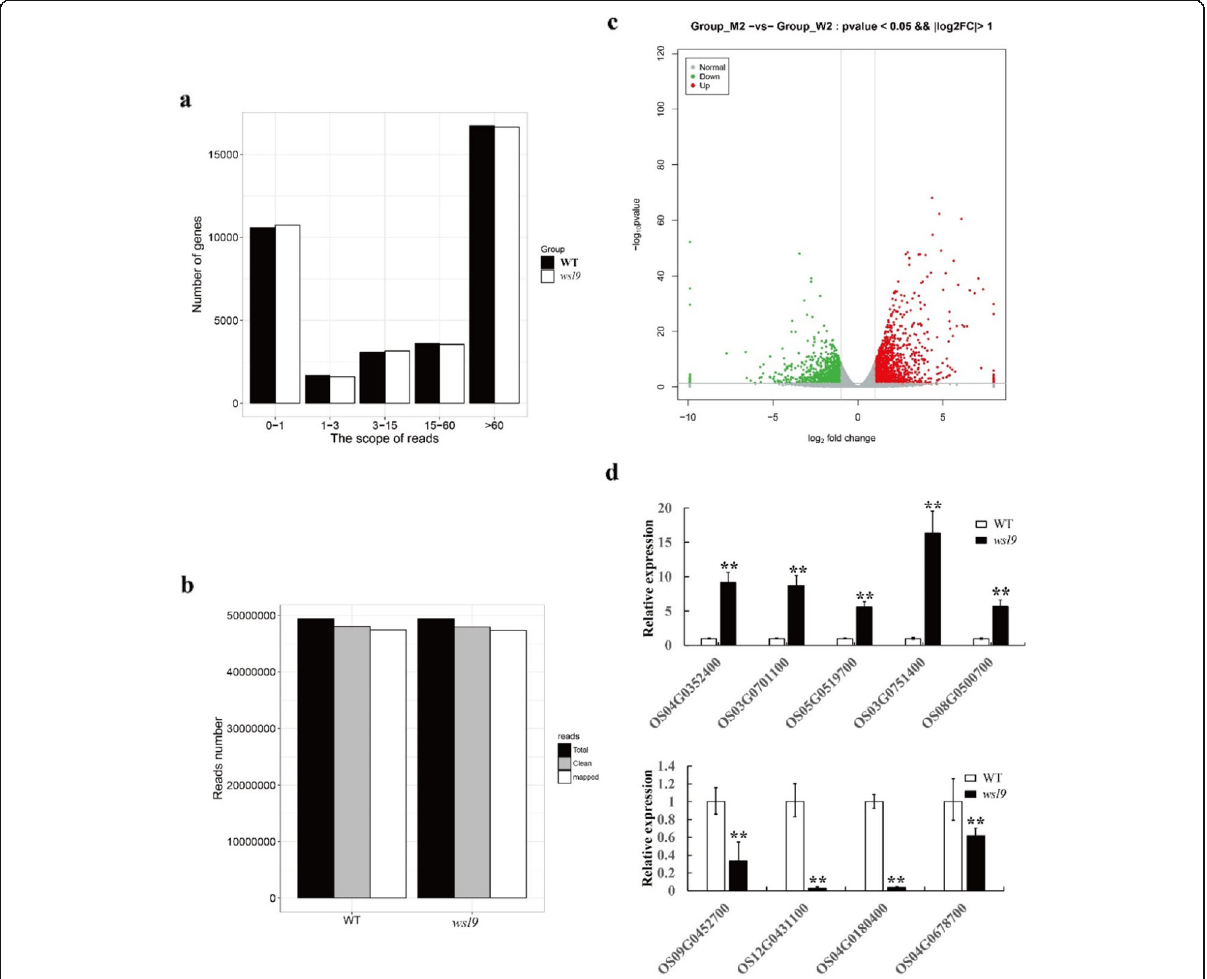
Fig. 9 RNA-seq analysis of wild-type and wsl9 seedlings under 20 °C conditions. mRNA enriched from total RNA isolated from 10-d-old seedlings of WT and wsl9 mutant using oligo-(dT) was fragmented and reverse-transcribed using random hexamer primers. The library was then constructed and sequenced using an Illumina HiSEquation 2000. a Frequencies of detected genes sorted according to expression levels. b Read numbers of WT and wsl9 mutant sequences. c Volcano plot showing overall alterations in gene expression in WT and wsl9 mutant . d qRT-PCR of genes differentially expressed in RNA-seq. Five up-regulated and four down-regulated genes were assayed. Error bars represent SD from three independent experiments. (Student ’ s t -test, **, P <